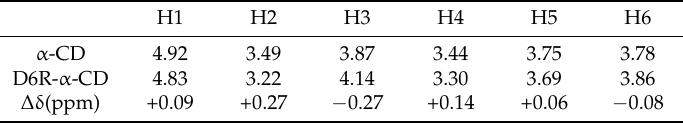
Table 2. Comparison of 1 H NMR chemical shifts 1 of D6R@ α -CD with respect to the free α -CD. H1 H2 H3